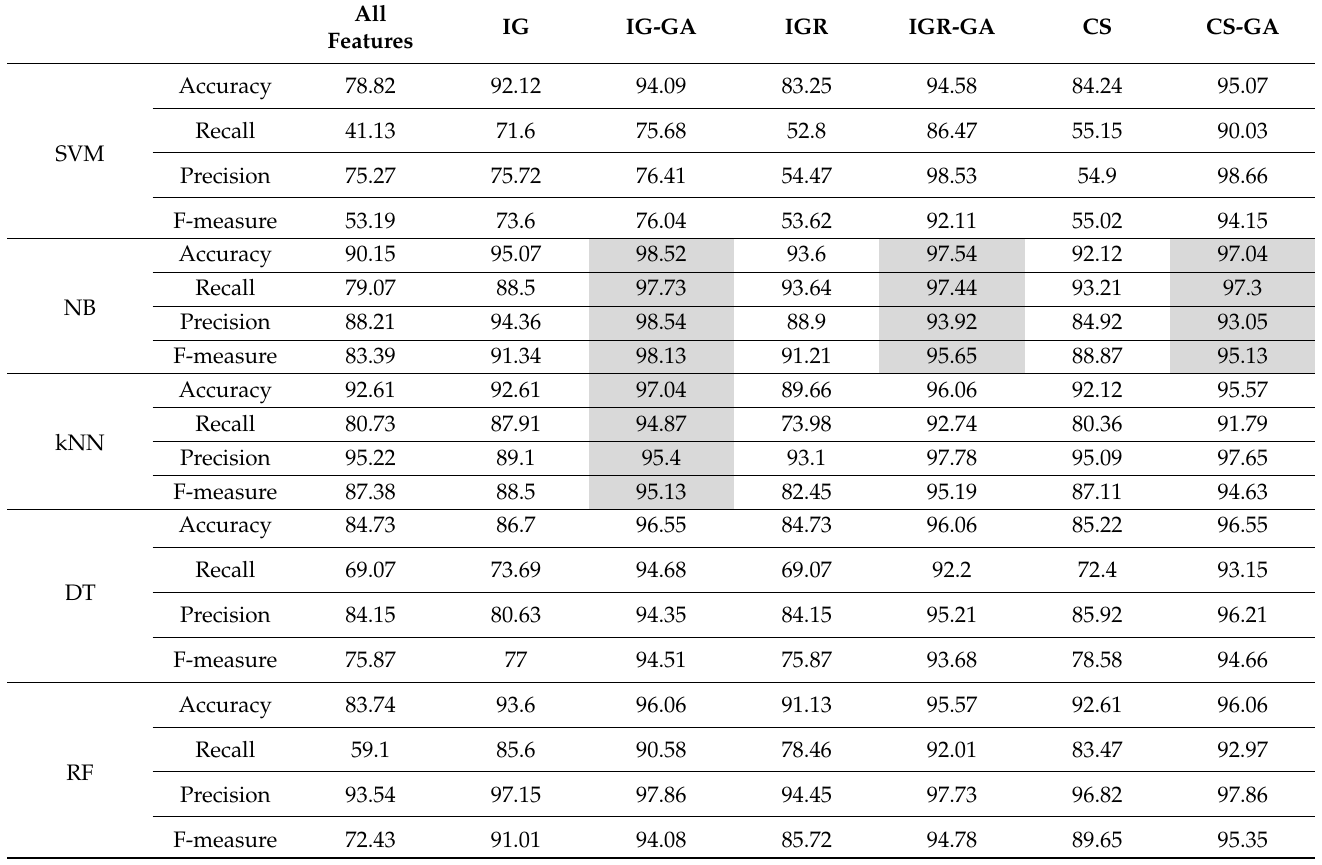
Table 5. The performance comparison of classifiers using all features, the features selected by filters methods, and the features selected by the proposed hybrid filter-GA methods on the Lung dataset.